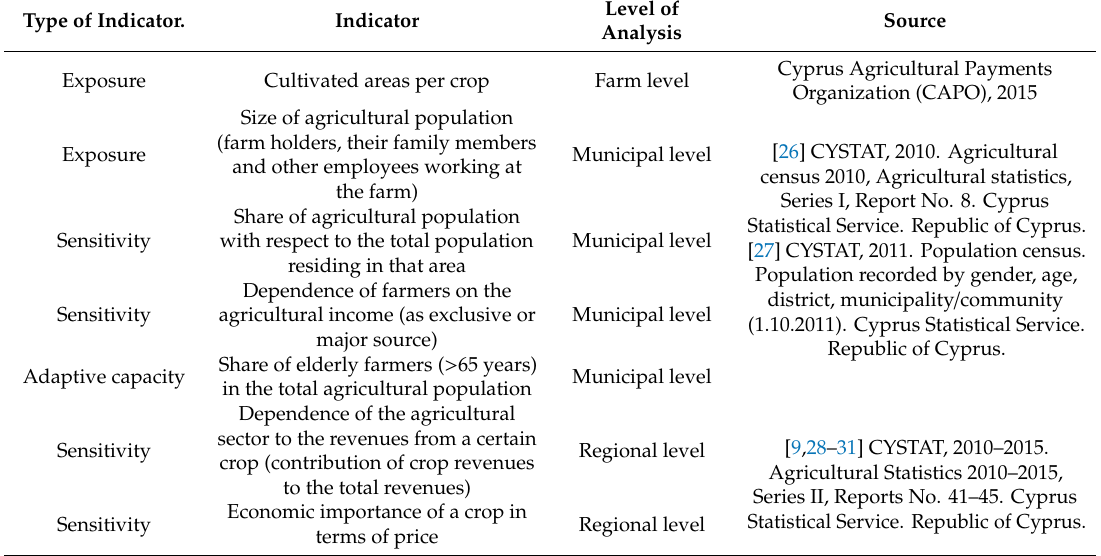
Table 5. Vulnerability indicators used in the impact assessment for the agricultural sector. Type of Indicator.